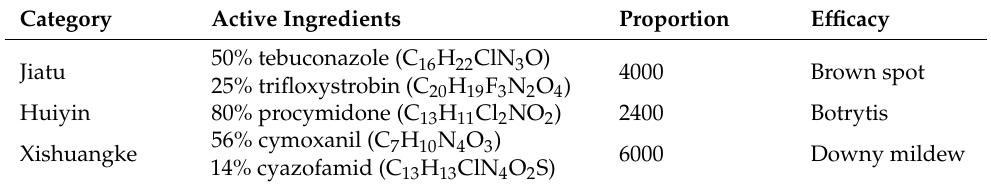
Table 2. Information about the pesticides used in the experiment. Category Active Ingredients